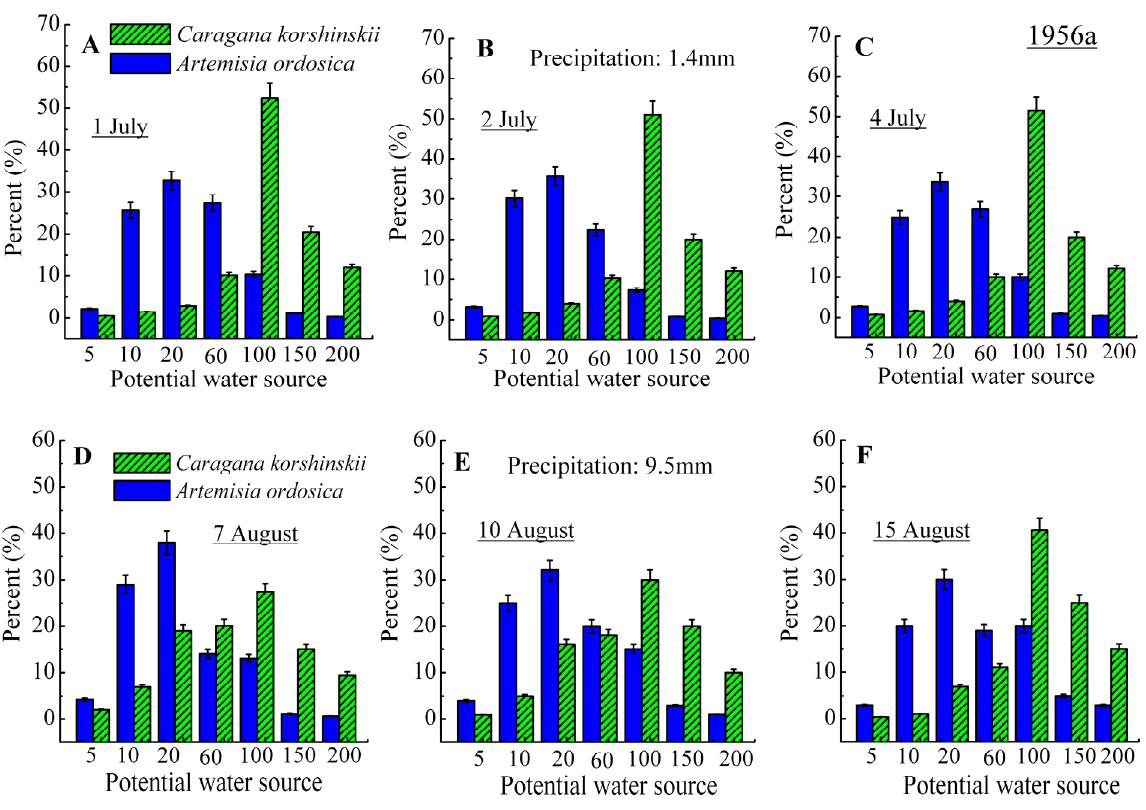
Figure 4. Proportion of potential water source for C. korshinskii and A. ordosica in